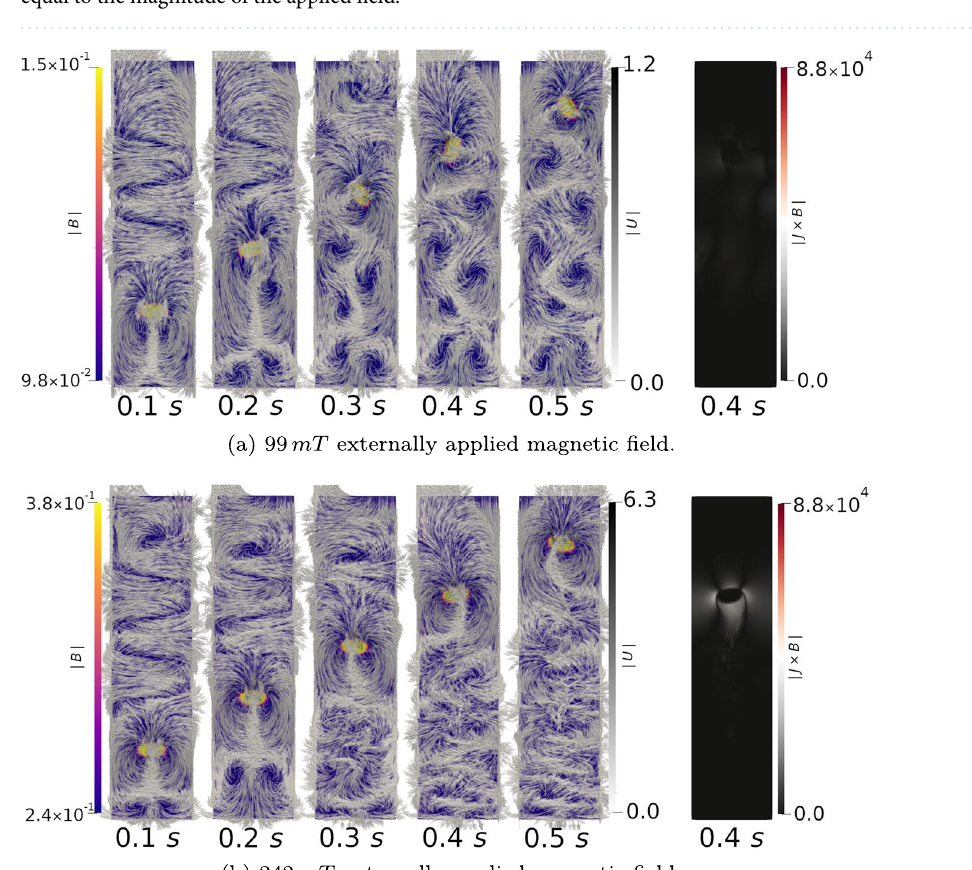
Figure 2. Initial Ar fraction and velocity perturbation used in the bubble rise simulations. The initial H field is also shown for the 505 mT case. In all four cases the initial H field is set such that B is uniform at t = 0 s and equal to the magnitude of the applied